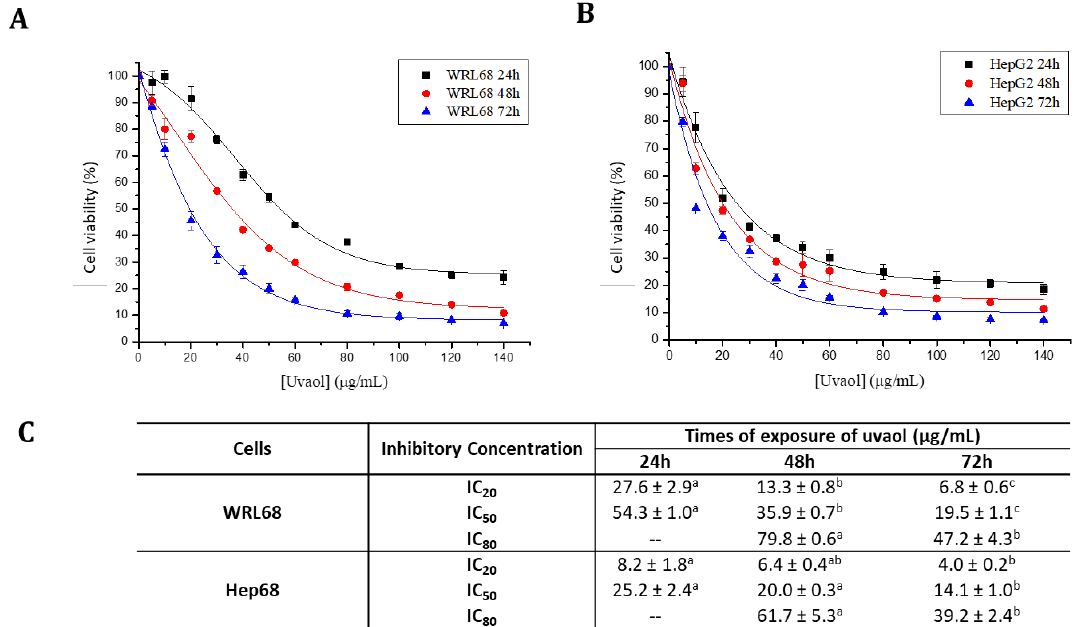
Figure 2. Cytotoxicity curves of uvaol during 24, 48 and 72 h in WRL68 ( A ) and HepG2 cells ( B ). IC 20 , IC 50 and IC 80 values for the WRL68 and HepG2 lines after 24, 48 and 72 h of incubation with uvaol ( C ). These values are represented by mean ± SEM (n = 9).